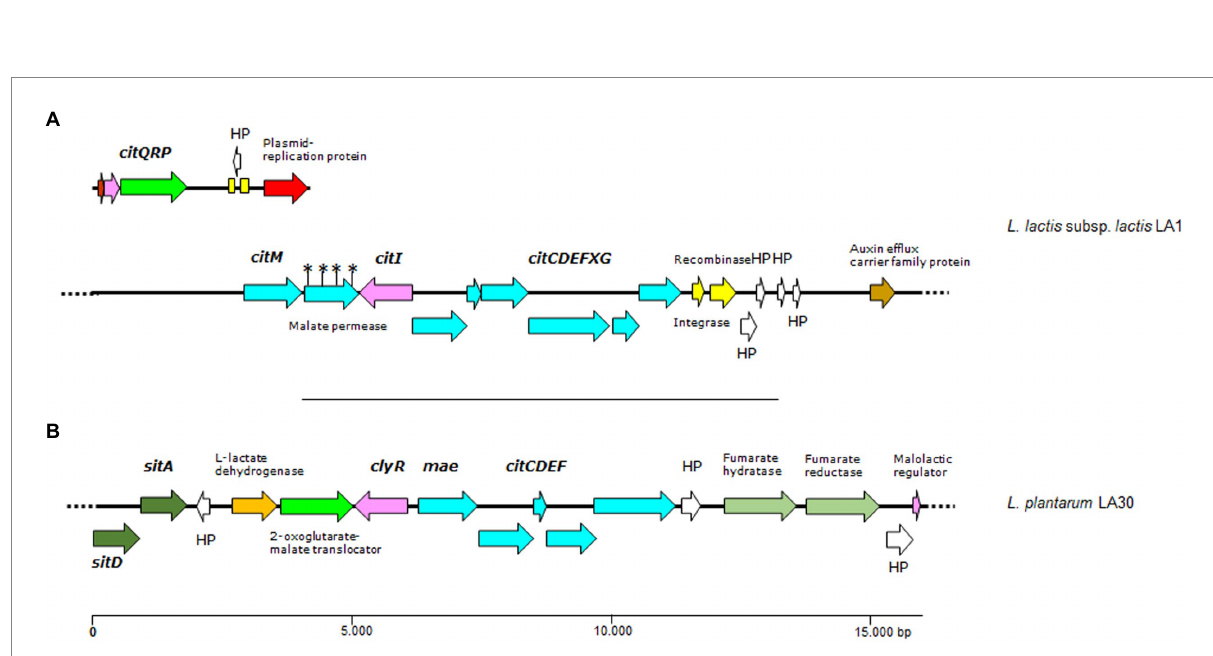
FIGURE 4 Genetic organization of citrate gene clusters ( A and B ) found in contigs of the genome of L. lactis LA1 and L. plantarum LA30. Color code: in pale blue, genes of the citrate operons ( citM-citCDEFXG ) and ( mae-citCDEF ); in green, genes involved in transport, including a plasmid-borne citrate permease ( citP ); in pink, genes encoding regulatory proteins; in yellow, genes encoding mobilization proteins; in white, genes encoding hypothetical proteins; any other color, other genes. Yellow boxes indicate DNA repeats, and the asterisks denote ORFs dirupted due to mutations disrupting a gene. Dotted lines as in Figure